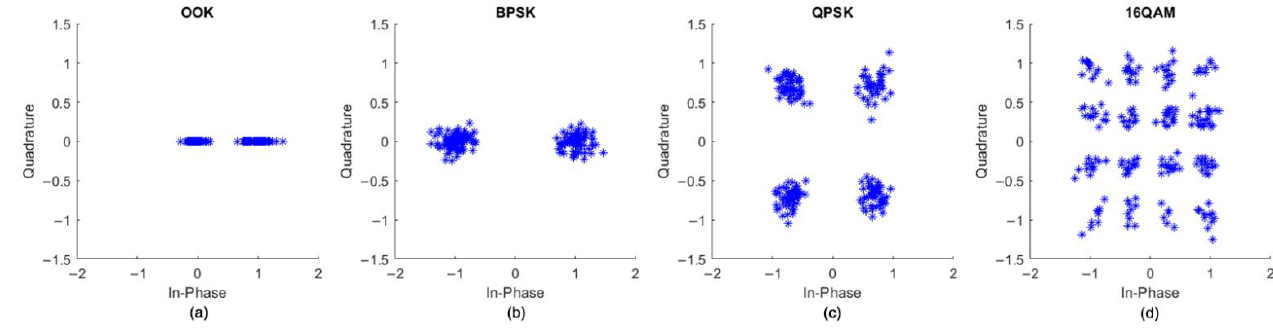
Figure 6. Spectrogram of the example frames. Weak turbulence with SNR = 10 is as an example above.